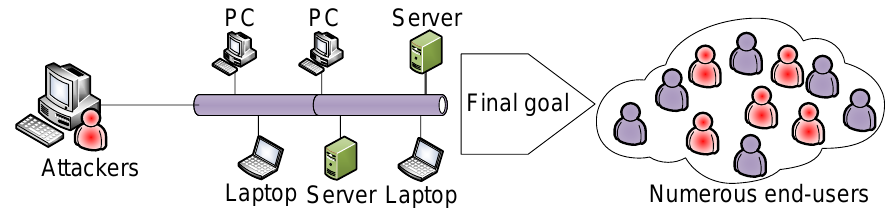
Figure 1. Worm propagation in the